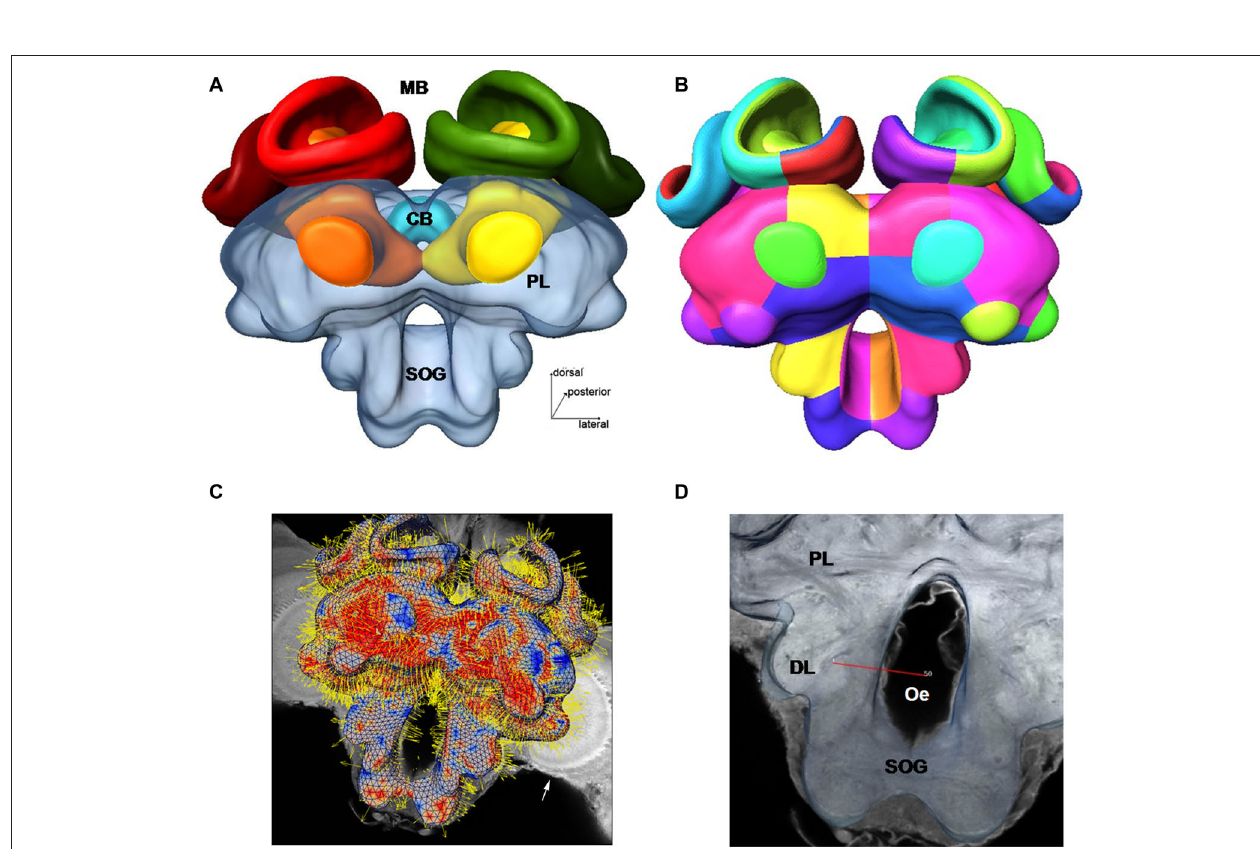
Figure 5 | (A) The surface of the statistical shape model (SSM) of the central honeybee brain (with exception of the antennal and optic lobes) derived from 16 segmented worker bee brains. The calyx regions of the mushroom bodies are not subdivided. (B) Patch decomposition: in order to find correspondence among the set of training data the surface of each segmented brain is subdivided into 89 patches (colored regions). (C) Position of the displacement of the bee brain model in the imaging data. Displacement vectors are shown as yellow arrows,